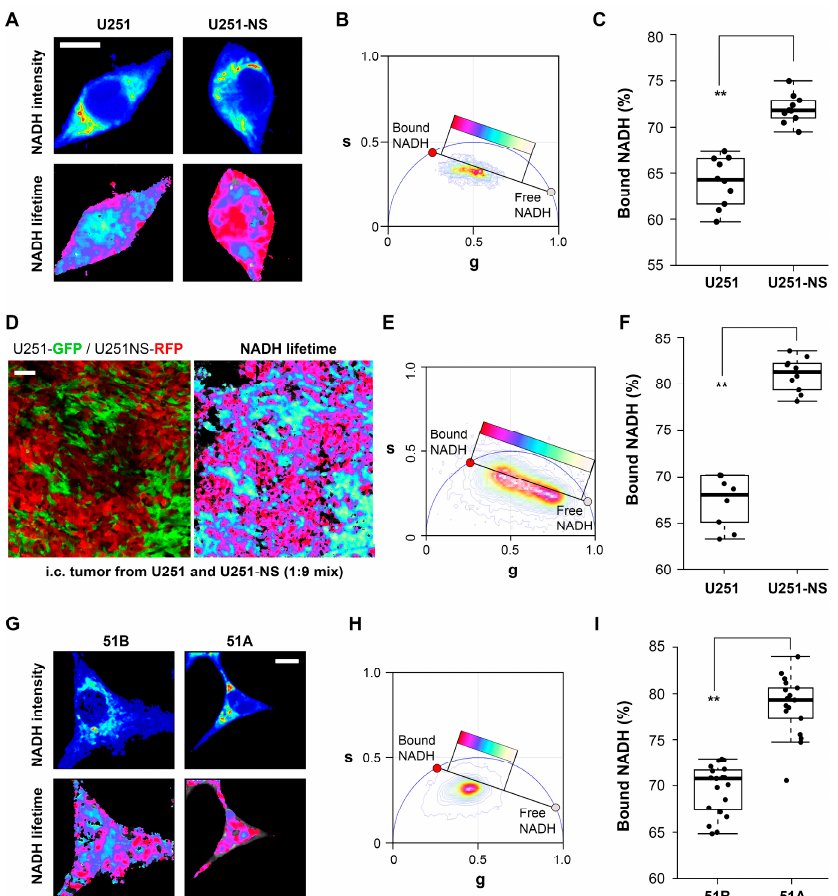
Figure 2. FLIM detection of differential fractions of bound NADH in STIC and TMC in two GBM heterogeneity models. ( A – C ) and ( D – F ) are in vitro cultures and intracranial (i.c.) xenografts of U251 and U251-NS, respectively; ( G – I ) are in vitro cultures of 51B and 51A. Representative images of FLIM ( A , G ) colored by NADH intensity with warmer colors representing higher intensity (top) and fluorescence lifetime of NADH (bottom) with colors represented by the location of each pixel on the phasor plot ( B , H ). A higher fraction of bound NADH is represented as red, and free NADH is represented as white. Boxplots represent the average fraction of bound NADH for individual cells and are calculated from the distance along the trajectory on the phasor plot from completely free NADH to completely bound NADH ( C , I ). Representative image of i.c. xenografts derived from co-implantation of U251-GFP and U251NS-RFP cells pre-mixed at a 1:9 ratio (total of 100,000 cells in 3 μ L) ( D ). Confocal fluorescence image of tumor (left) and the same section imaged by FLIM (right) with NADH fluorescence lifetimes pseudo-colored by the location of each pixel on the phasor plot ( E ). A higher fraction of bound NADH is represented as red, and free NADH is represented as white. Boxplots represent the average fraction of bound NADH for individual cells and are calculated from the distance along the trajectory on the phasor plot from completely free NADH to completely bound NADH ( F ). Individual cells and their corresponding subpopulation were identified by their fluorescent protein label. For the boxplots, boxes represent the first quartile, median and third quartile. Each point on the plot represents a single cell. Scale bars represent 10 μ m in ( A , G ) and 50 μ m in ( D ). ** p < 0.001.